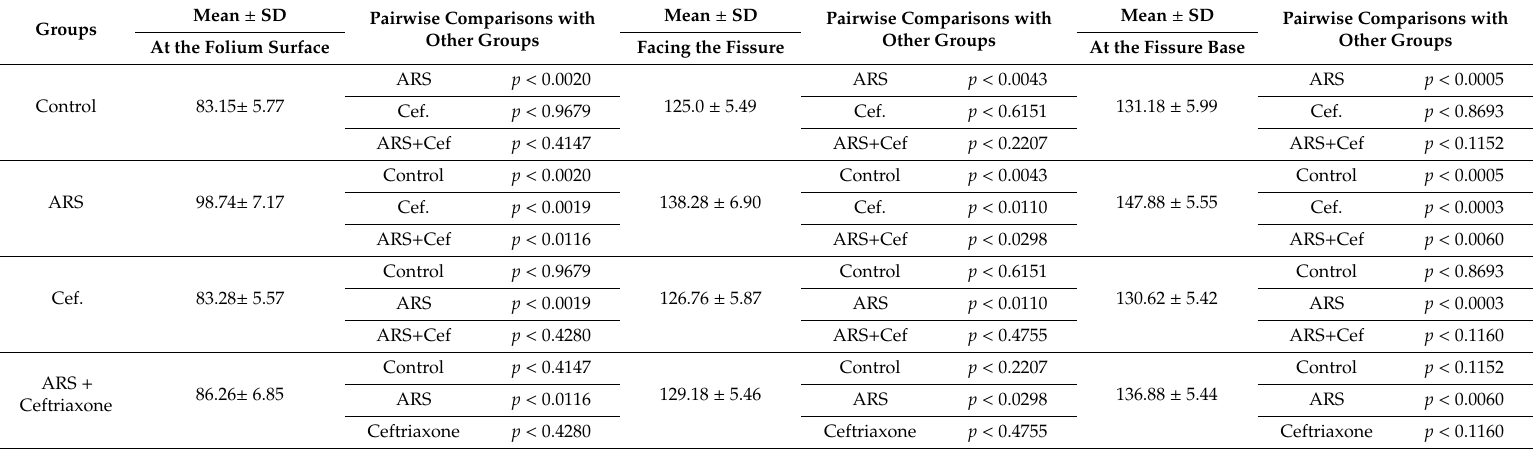
Table 5. Morphometric analysis of the molecular cell layer thickness at three di ff erent areas of the cerebellar folia.